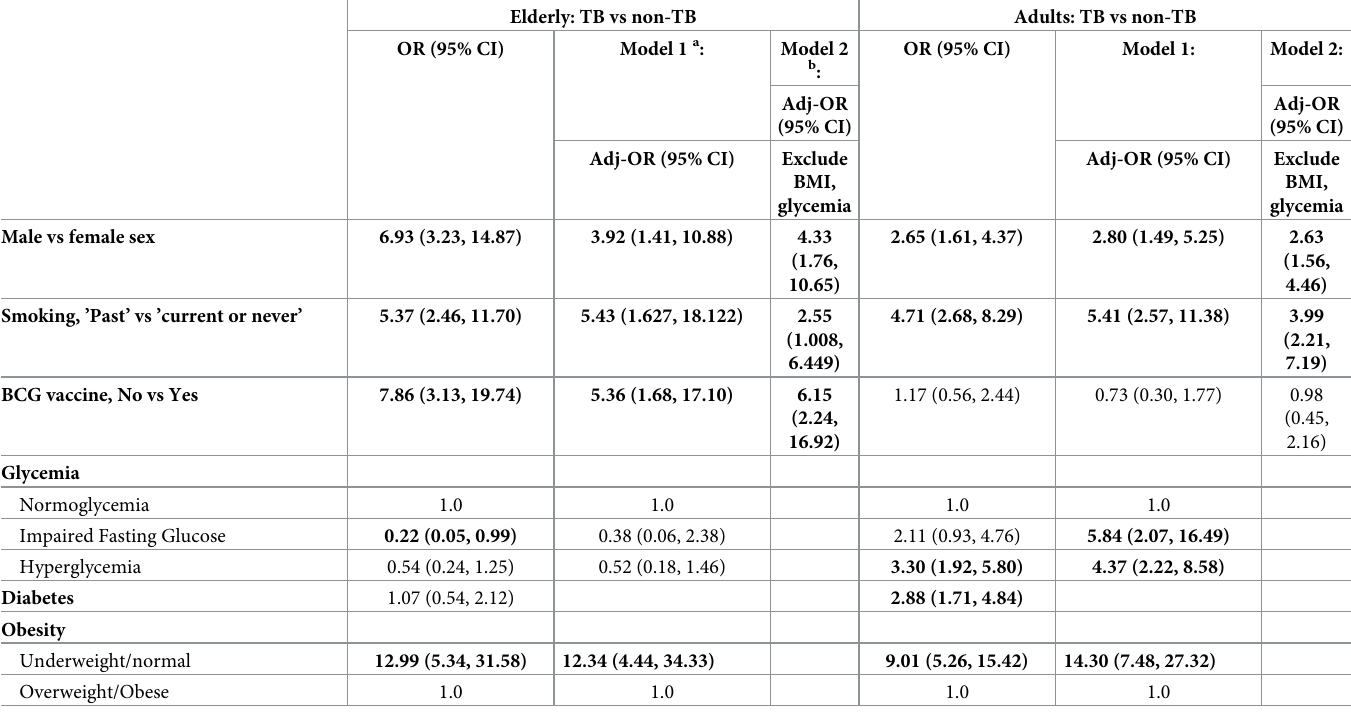
a Model-1. Controlled for all variables in the table.